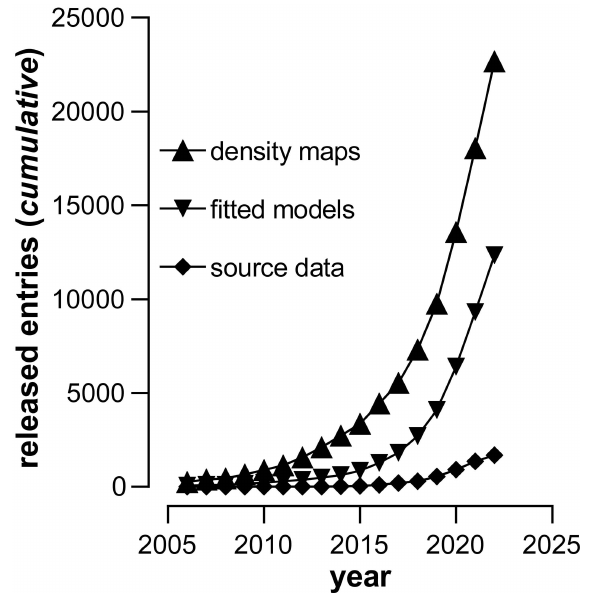
Figure 1 The growing impact of cryo-EM on structural biology. Cumulative number of density maps released at the electron microscopy data bank (triangles), fitted models derived from cryo-EM datasets deposited at the protein data bank (inverted triangles), and source micrographs or particle stacks available at the electron microscopy public image archive (diamonds). Source data were retrieved from the electron microscopy data bank on 6 October